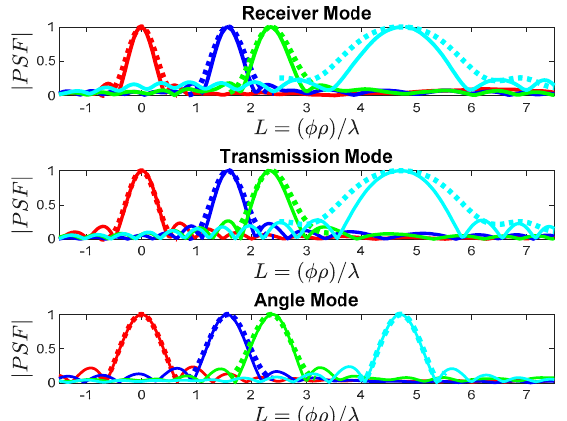
Figure 6. Comparison between the actual PSF (solid lines) and the approximation (cid:103) PSF (dotted lines) for three modes for φ 0 = 0 (red lines), φ 0 = π /6 (blue lines), φ 0 = π /4 (green lines) and φ 0 = π /2 (cyan lines).